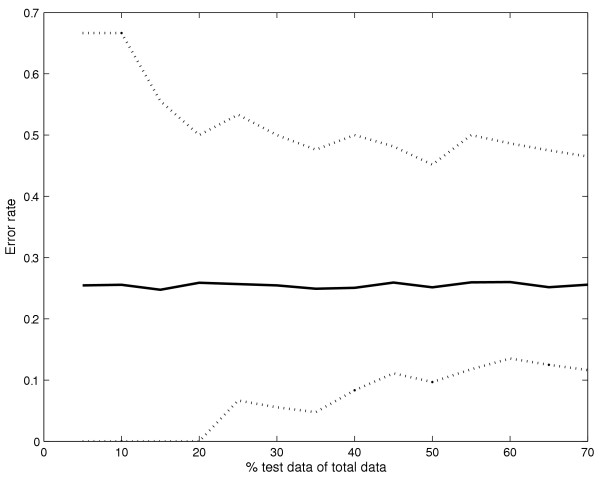
Repeated random sampling with different test set sizes. Results from repeated random sampling where the size of the design sets was set to 30% of the total sample size and the size of the test set was varied from 5% to 70%. For each test set size the data was divided randomly into design and test sets 1,000 times, with the class proportions kept constant. The endpoints (dotted) of a two-sided 95% CIs, based on a histogram of 1,000 estimates, is displayed for the different values of the test set size, Nt. Apparently the widths of the empirical CIs decrease as Nt increases. Also displayed are the estimated averages as a function of the test set size (solid). Since each CI is based on the histograms instead of estimates of the average and variance, note that the CIs are asymmetric with respect to the estimated average.